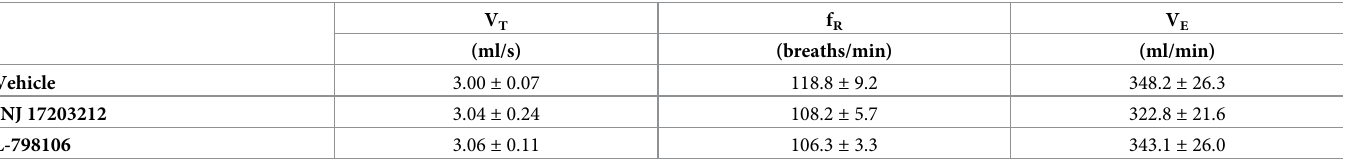
Fig 2. Effects of inhalation of vehicle (Veh), TRPV1 antagonist (JNJ 17203212, JNJ) or EP3 receptor antagonist (L-798106) on the PGE 2 -evoked (A) and CA-induced cough (B). n = 7/subgroup; � P < 0.05 and �� P < 0.01 as compared to Veh. † P < 0.05 and ‡ P < 0.01, L-798106 vs. JNJ 17203212 pretreatment. https://doi.org/10.1371/journal.pone.0246375.g002 Table 1. Baseline ventilation before and after pre-inhalation of JNJ 17203212 or